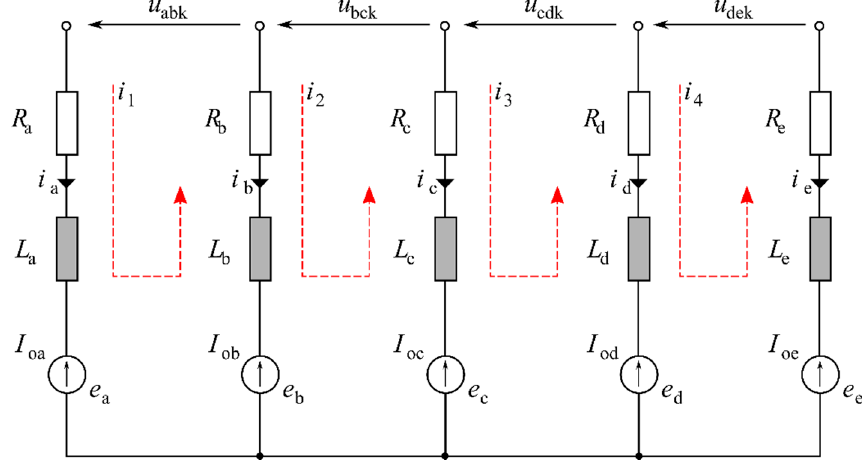
Figure 5. The circuit of the five-phase two-level inverter with the star connected load.